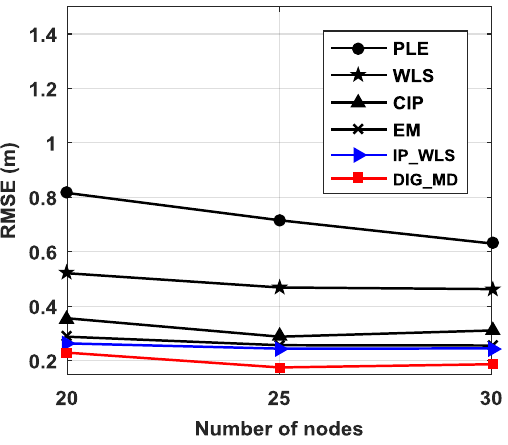
Figure 15. RMSEs for different numbers of nodes.